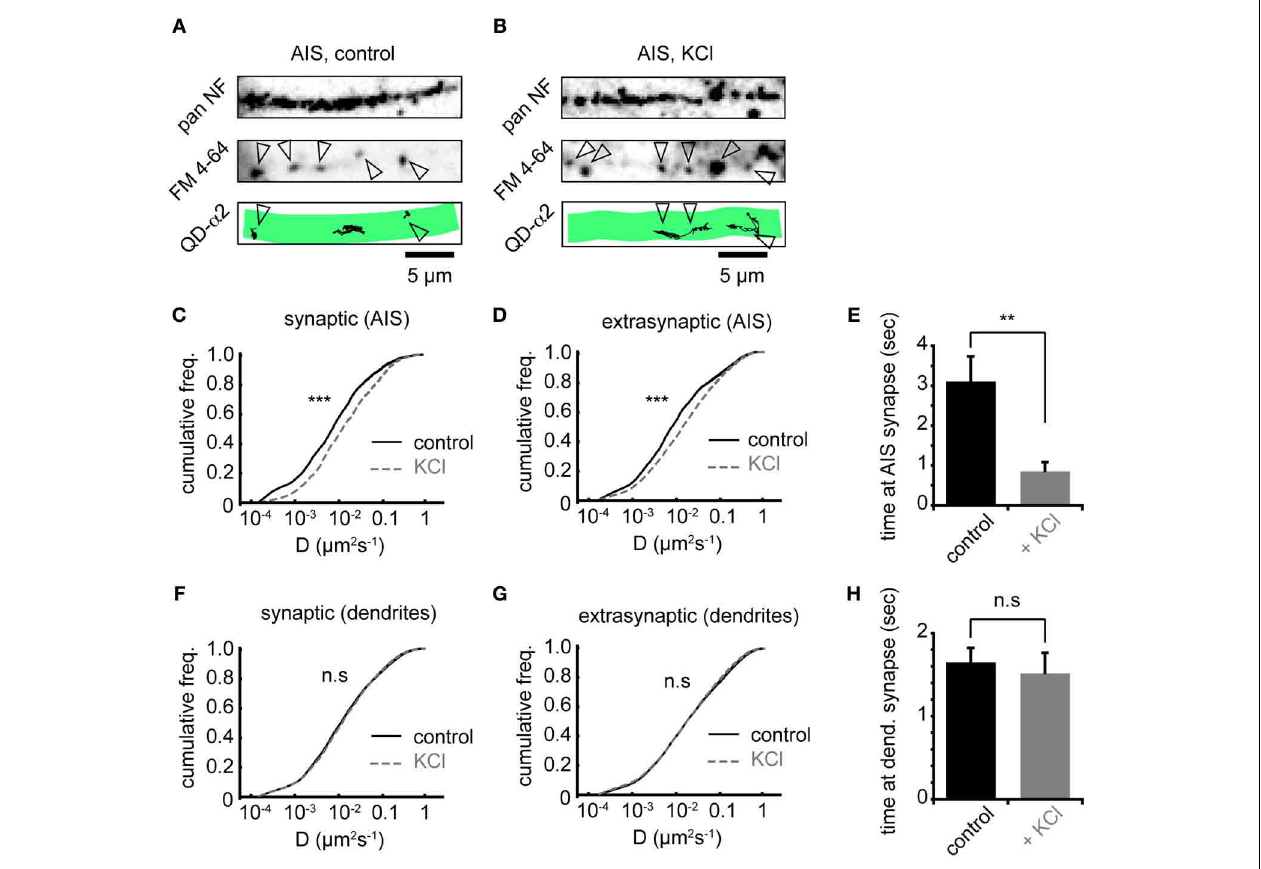
FIGURE 4 | Chronic depolarization affects synaptic and extrasynaptic GABA A Rs, and reduces GABA A R residency time at AIS synapses. (A) Control neuron AIS labeled by pan NF (top), FM 4–64 loading (middle, arrowheads = synapses) and with QD- α 2 tracks shown (bottom). (B) As in (A) , but for KCl-treated neuron. (C) Chronic depolarization increases GABA A R lateral mobility in the AIS at synapses (1.85-fold increase, n control = 1922, n KCl = 1620, p < 2 × 10 − 16 ). (D) GABA A R lateral mobility in the AIS also increases outside synapses (1.89-fold increase, n control =